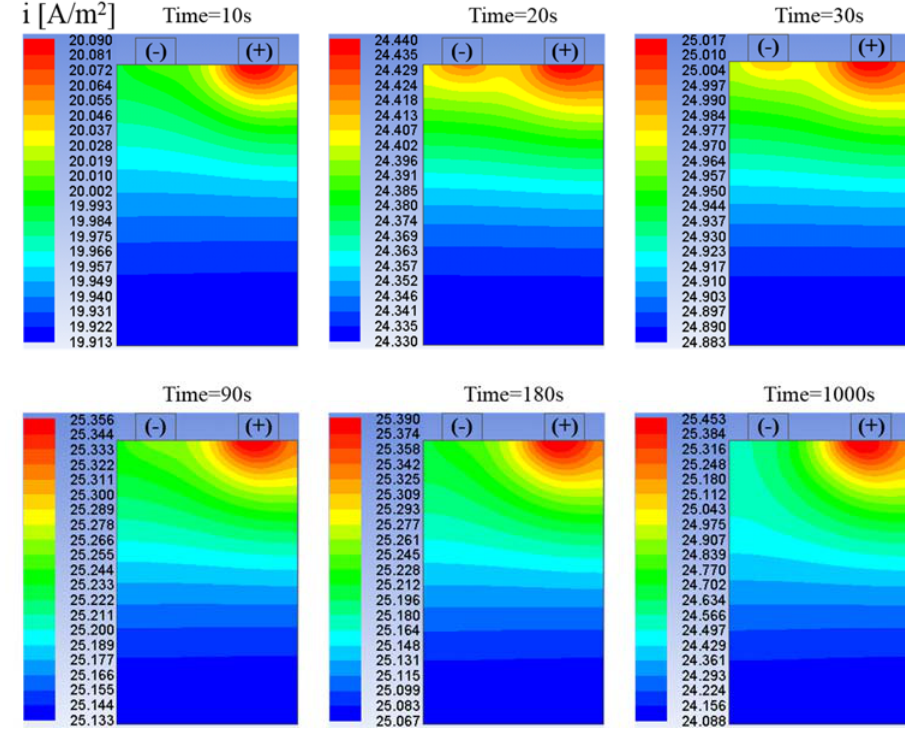
Figure 12. Current density distribution over the separator at a 2C rate for six different discharge elapsed times of 10 s, 20 s, 30 s, 90 s, 180 s and 1000 s.